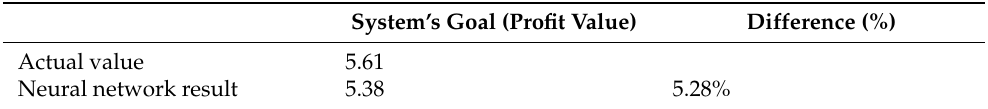
Table 3. Actual and experimental result.